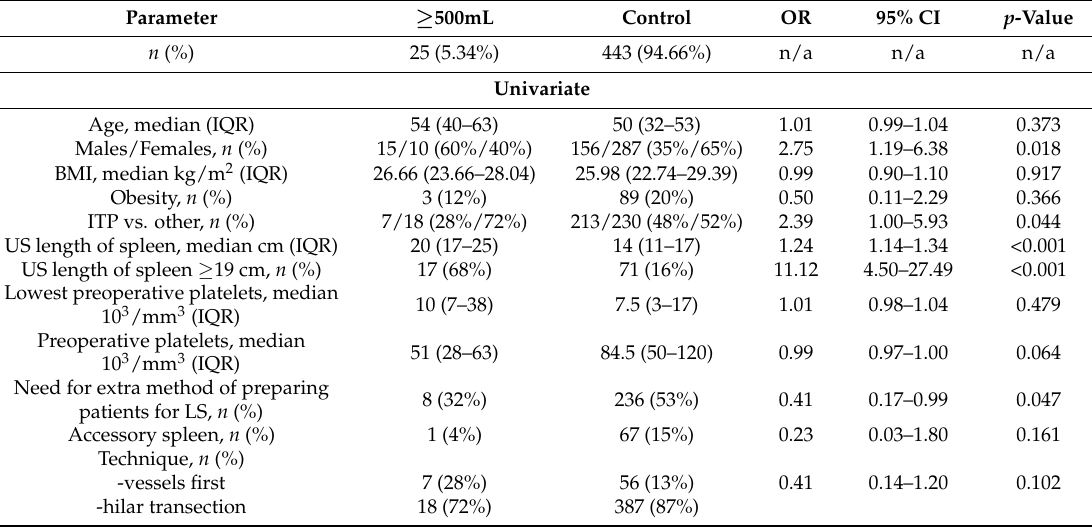
Table 8. Risk factors for intraoperative blood loss ≥ 500